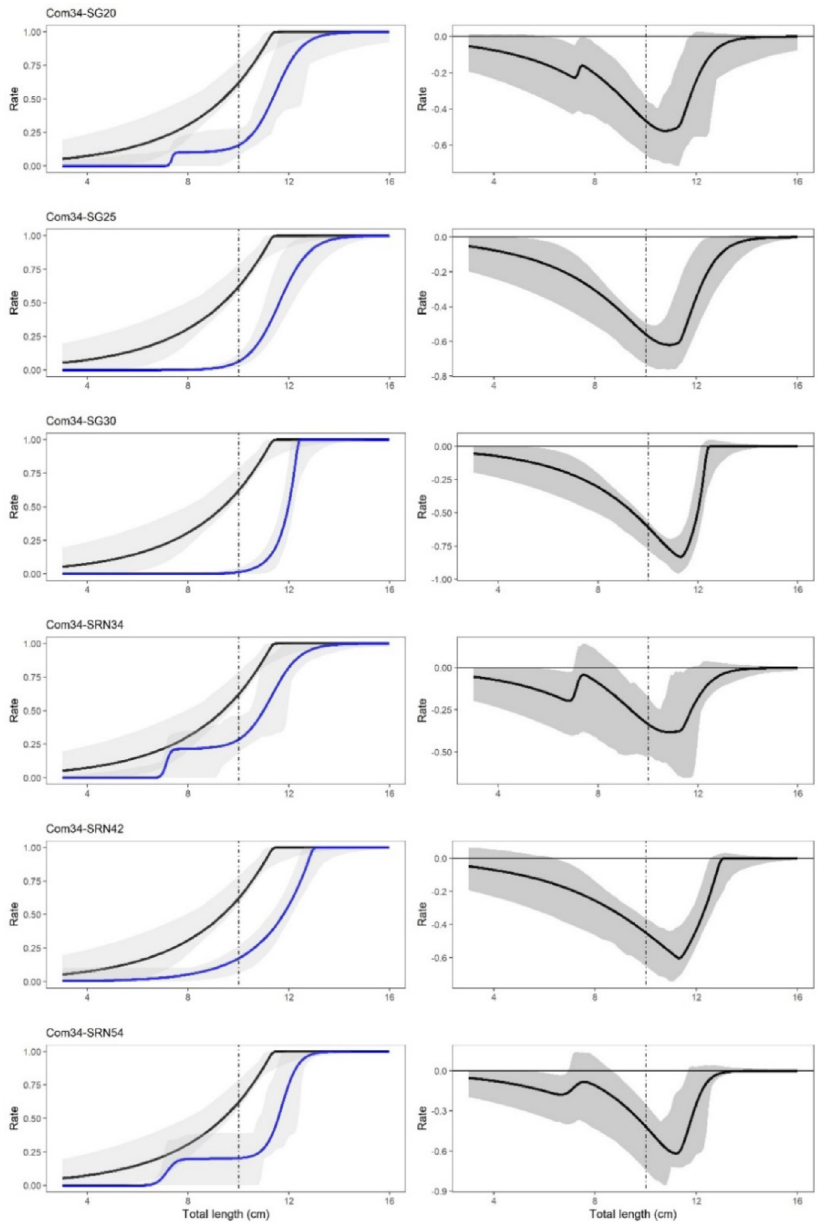
Fig. 4. Left: comparison of the selection curves of commercial fyke nets with experimental codends (black lines represent Com34 , blue lines represent the experimental codends, vertical dashed lines represent the MLS for P. leptodactylus and light grey areas describe 95% CIs ). Right: delta curves for each pair of codends (black curves indicate the fi tted delta curves and dark grey areas describe the 95% CIs